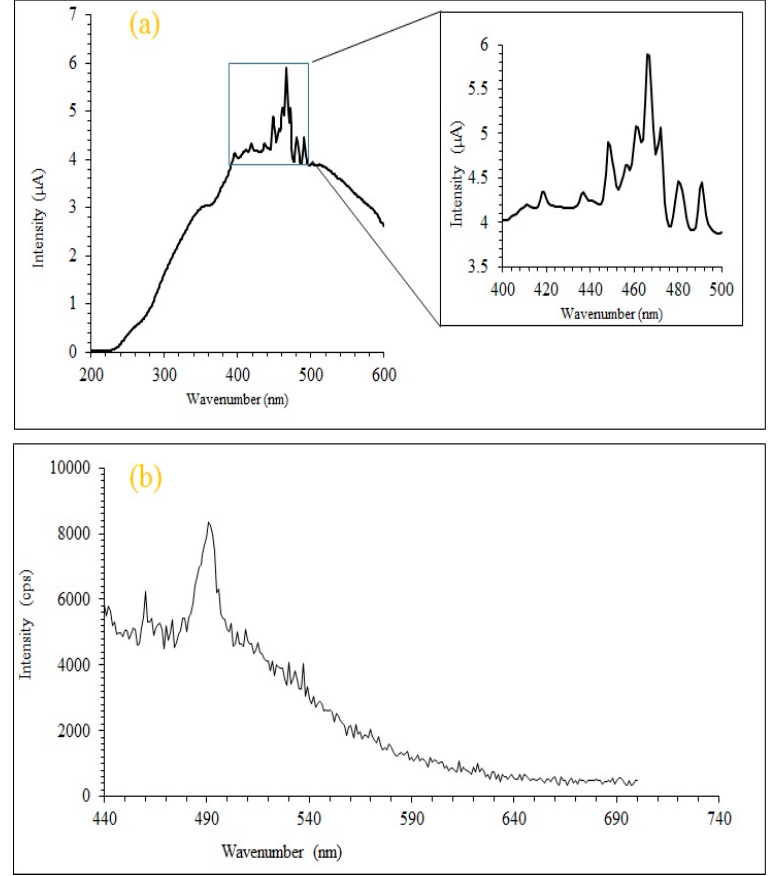
Figure 5. ( a ) Full range excitation spectrum of MA-AC400 (400–500 nm); ( b ) emission spectrum of MA-AC400 excited at 420 nm.